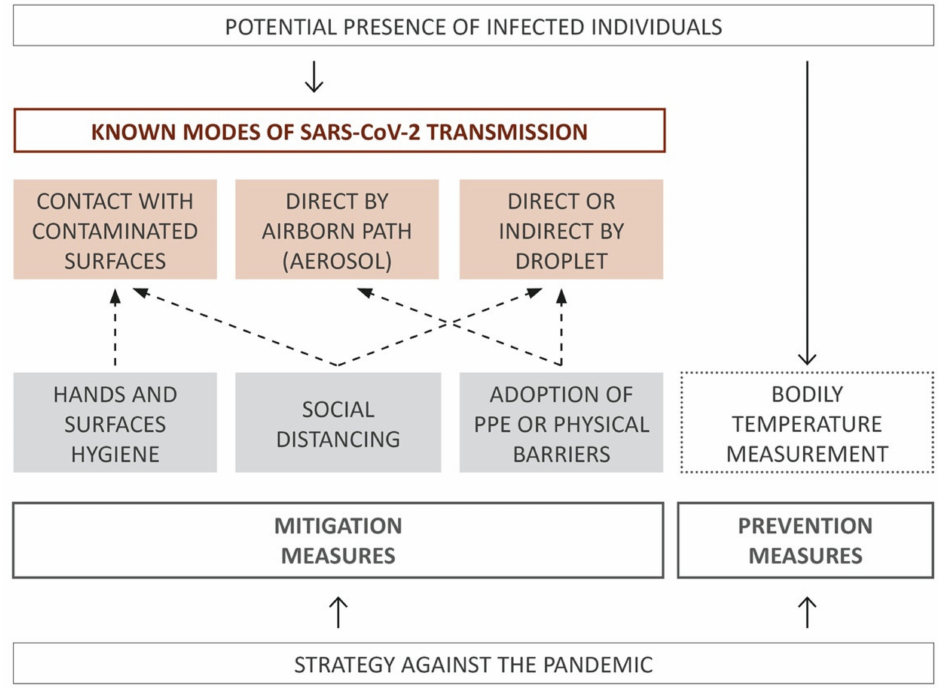
Figure 2. Relationships between the three known modes of SARS-CoV-2 transmissions and the common related anti-COVID measures implemented. As it emerged, none of them, individually considered, allows for fully avoidance of the contagion. Own